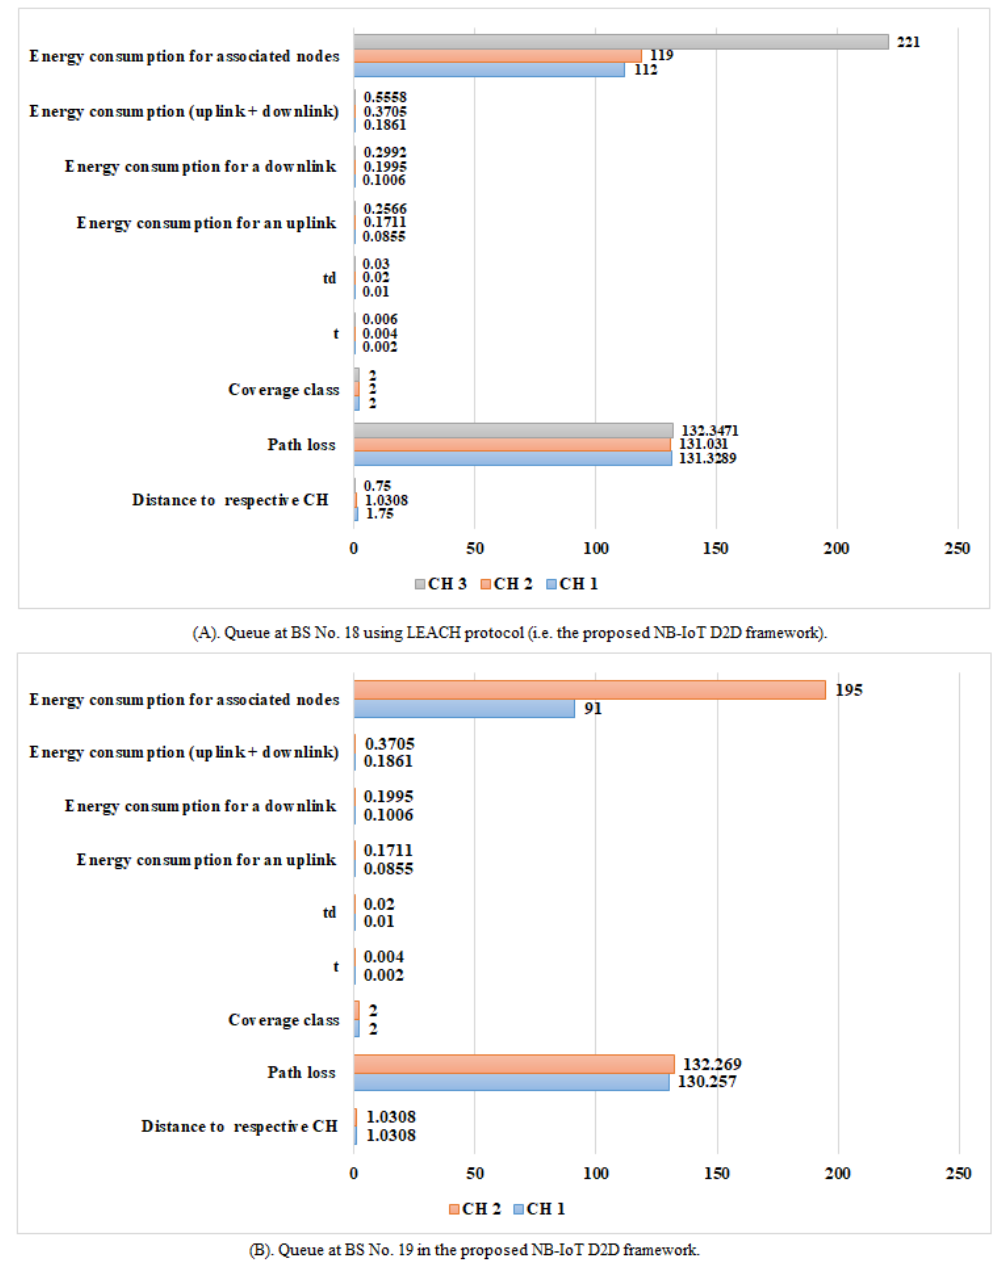
Figure 25. Queue at BSs No. 18 and No. 19 in the proposed NB-IoT D2D